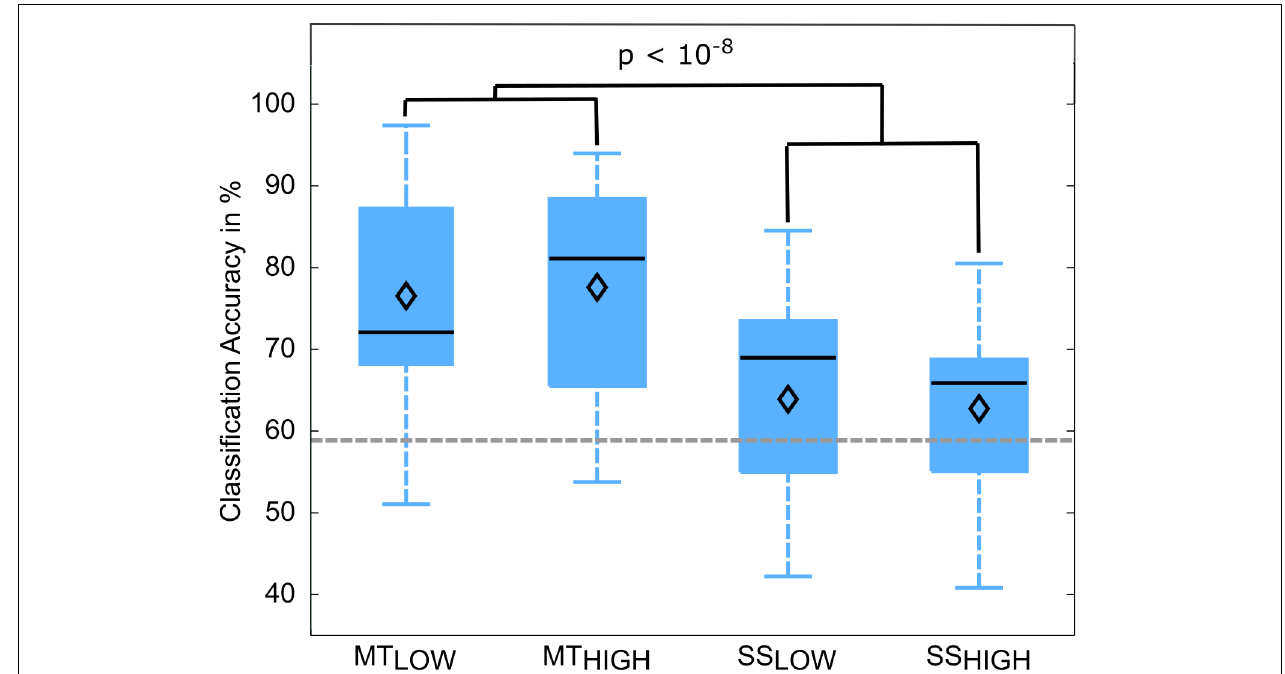
FIGURE 6 | Box plots depicting the classification accuracies of the four regular classifiers (RC) using alpha band features averaged across all subjects. All classifiers performed a binary classification of an experimental condition vs. rest. Classifiers were trained and tested using a five-fold cross-validation. Each of these classifiers performed significantly above chance. MT classifiers reached significantly higher classification accuracies than sensory stimulation (SS) classifiers ( p < 10 − 8 ). The vertical dotted gray line depicts the statistical chance level (58.9%). Mean classification accuracies are depicted by the diamond. Central lines within the boxes represent the